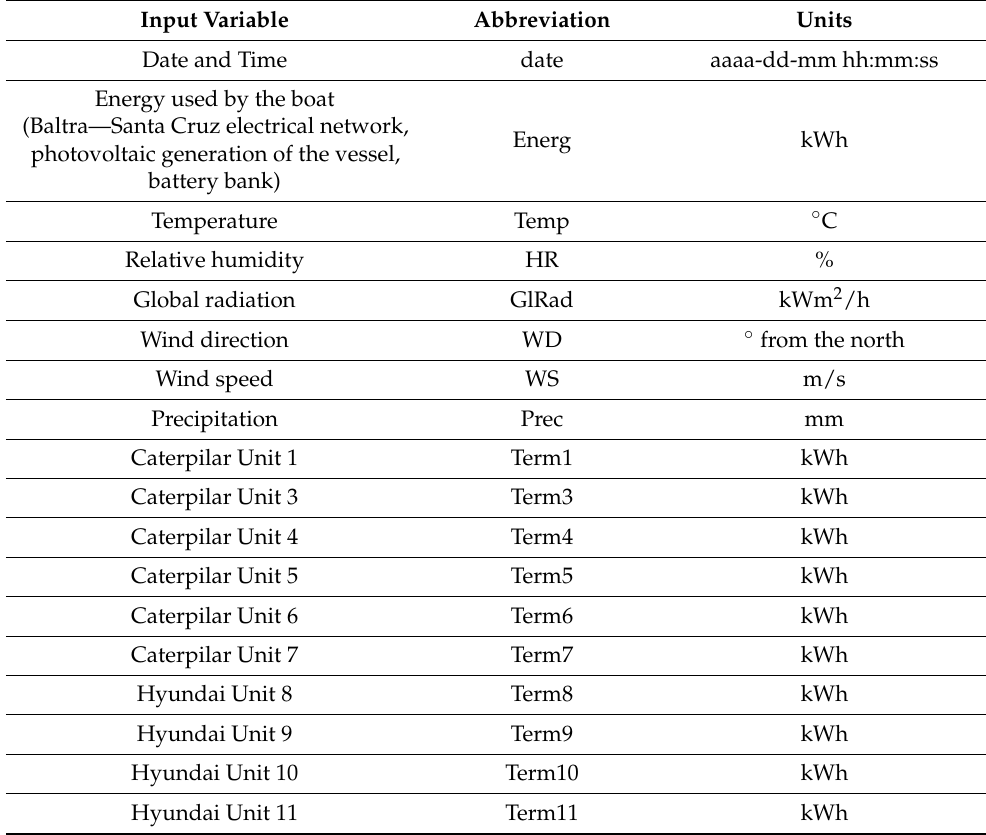
Table 1. Study variable